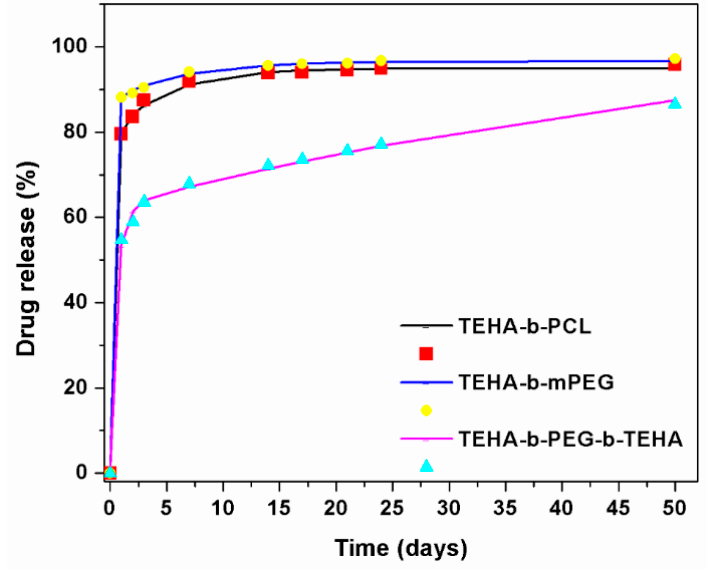
Figure 10. Comparison between model and experimental data of NLX release.